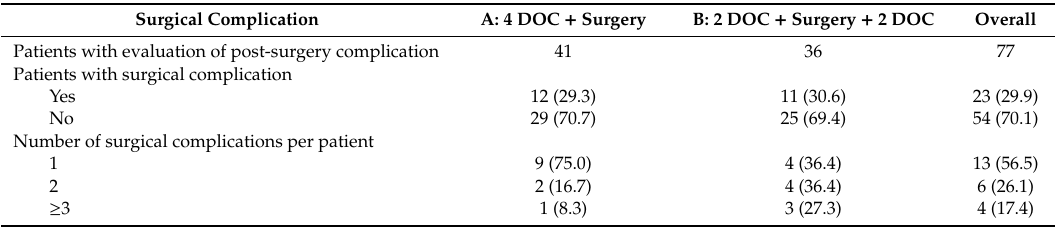
Table 4. Surgical